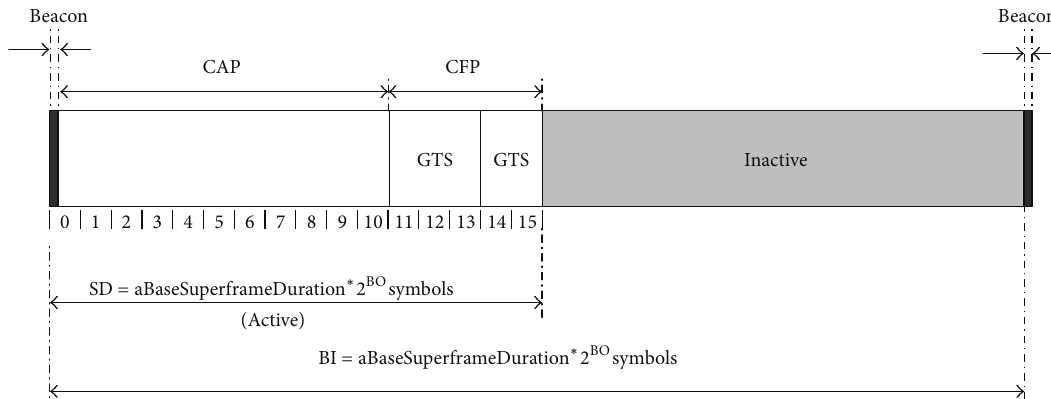
F 9: An example of superframe structure